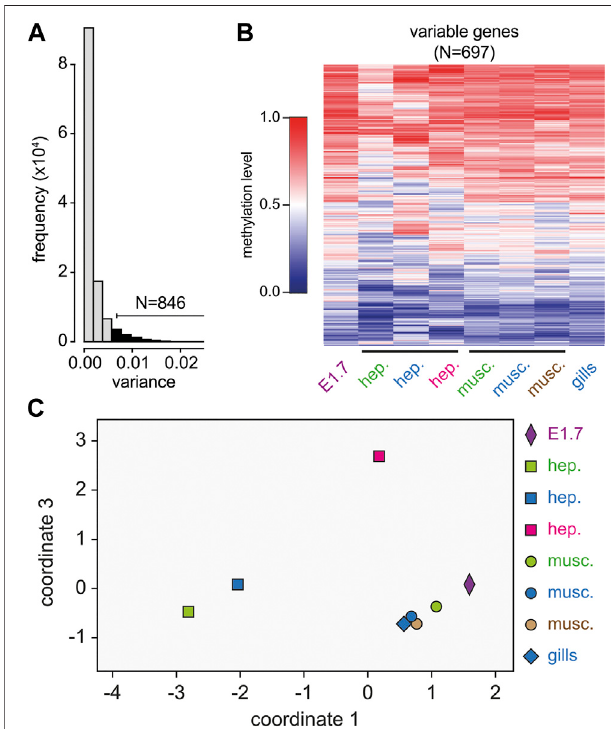
FIGURE 2 | Identi fi cation and characterization of variably methylated genes by whole-genome bisul fi te sequencing. (A) Density plot of methylation varianceforthe12,244geneswithsuf fi cientcoverageinalleightsamples.846 of these genes had a methylation variance > 0.06. (B) Heatmap showing average gene body methylation levels for the 697 variably methylated genes with a mean ratio > 0.2 and < 0.8 in eight independent samples (columns). Methylation levels are indicated on a scale from 0 (blue) to 1 (red). (C) Metric multi-dimensional scaling analysis of all eight samples based on the methylation levels of the 697 variably methylated genes. E1.7: embryonic stage 1.7, hep.: hepatopancreas, musc.: abdominal muscle. Colors indicate samples from individual